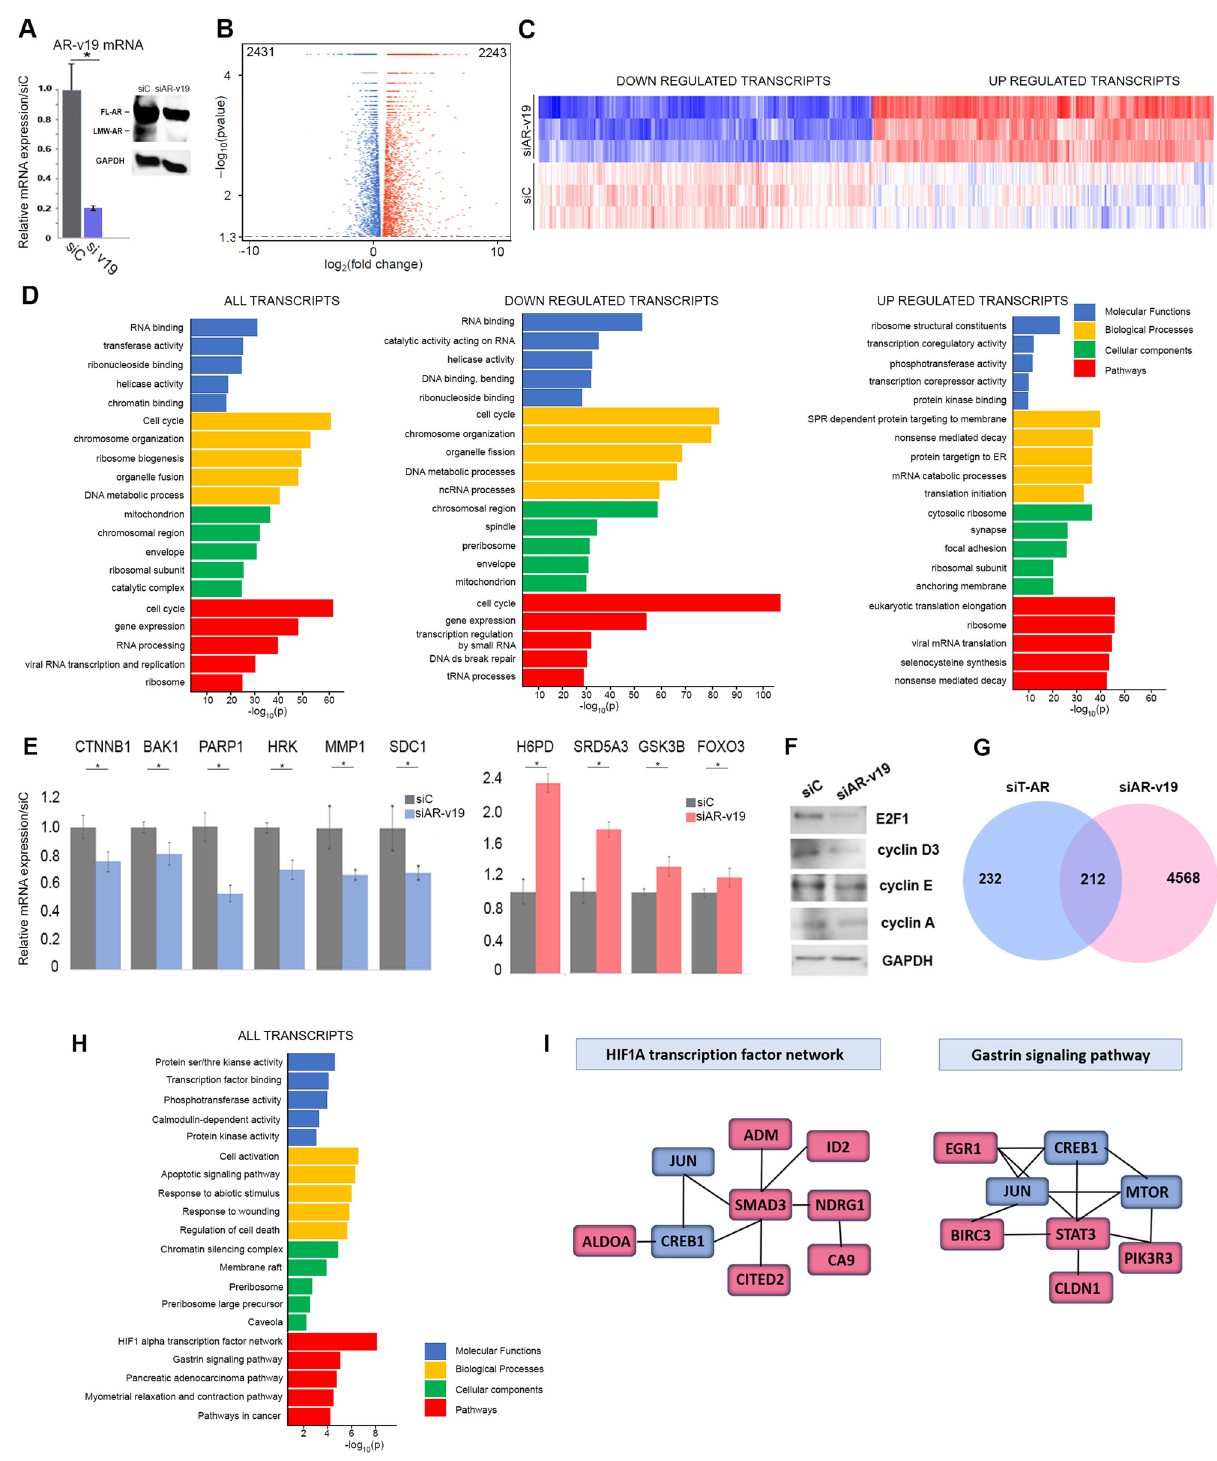
Figure 4. Transcripts regulated on depletion of AR-v19 splice variant. ( A ) qRT-PCR (left panel) and immunoblot (right panel) verification of AR-v19 depletion. ( B ) Volcano plot indicates that on AR-v19 depletion similar numbers of transcripts are activated (red) and repressed (blue). ( C ) Partial heatmap of transcripts altered by AR-v19 depletion. ( D ) Gene enrichment analysis of transcripts altered on AR-v19 shows a steep decline in transcripts involved in all aspect of cell proliferation. ( E ) qRT-PCR verified alterations of selected transcripts. ( F ) Immunoblot analysis of key cell cycle proteins following AR-v19 depletion. ( G ) Venn diagram of differentially and commonly regulated transcripts on depletion of all AR isoforms (blue) or AR-v19 (pink). ( H ) Gene enrichment analysis of transcripts commonly regulated on T-AR and AR-v19 depletion. ( I ) HIF1 and Gastrin Pathways are altered on T-AR and AR-v19 depletion. Downregulated transcripts- blue, upregulated transcripts- red. qRT-PCR analyses were conducted in triplicate. * P -value < 0.05. Immunoblots were cropped prior to incubation with specific